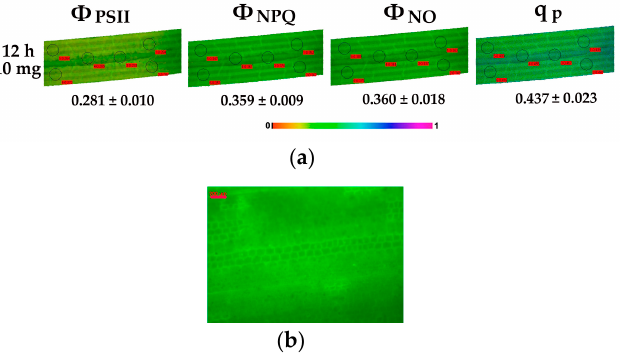
Figure 10. Representative chlorophyll fluorescence images after 5 min illumination at 200 μ mol photons m − 2 s − 1 actinic light of Φ PS ΙΙ , Φ NPQ , Φ NO , and q P of C. nodosa leaf blades exposed to 10 mg L − 1 ZnO NPs for 12 h. The colour code depicted at the bottom of the images ranges from 0.0 to 1.0. The average values are presented for each photosynthetic parameter ( a ). Below is the representative pattern of H 2 O 2 production in a C. nodosa leaf blade exposed for 12 h to 10 mg L − 1 ZnO NPs. Scale bare: 200 µ m. Increased H 2 O 2 content is indicated by light green colour ( b